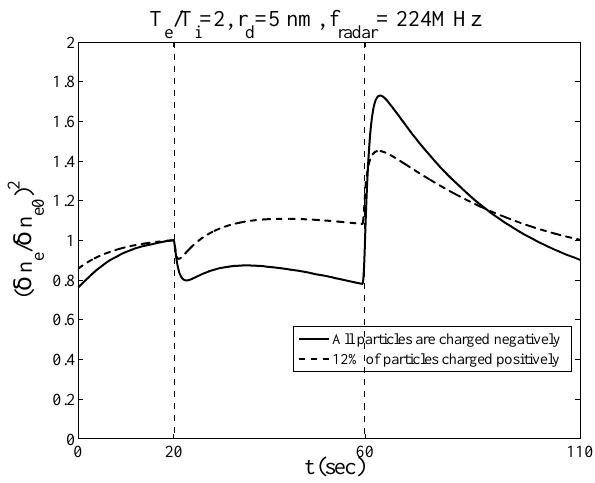
Fig. 9. The predicted effect of positively charged dust particles on the electron irregularity amplitude during PMSE heating experiments at VHF (224MHz).